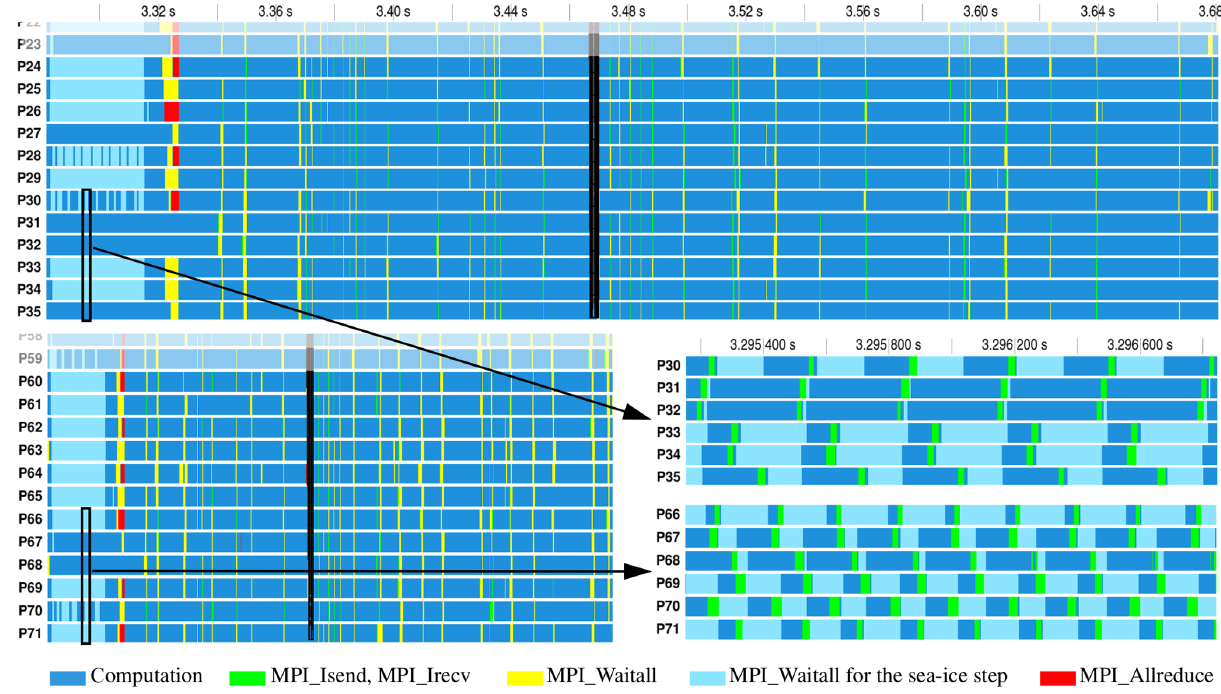
Figure 7. One FESOM2 time step on the CORE2 mesh with 36 MPI tasks (above) and 72 tasks (below) visualized in Intel Trace Analyzer and Collector. Zoom-in views of iterations of the sea-ice model (bottom right) show the load imbalance between processes with differing amounts of sea-ice per process and illustrate reasons for a suboptimal parallel scaling: with twice the number of cores, the computation time (blue) for parallel partitions fully covered by sea ice halves; however, the halo exchange time (green) increases.